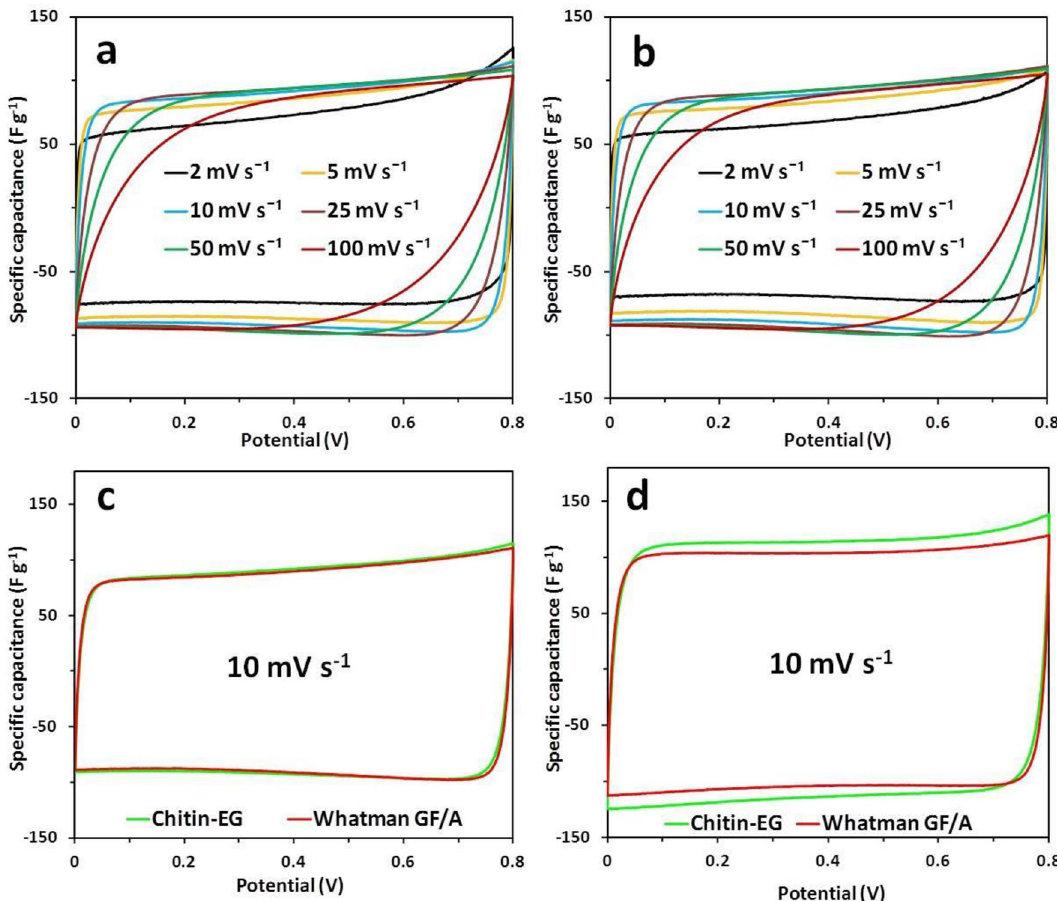
Figure 8. CV curves of EDLC test cells with ( a ) chitin–EG hydrogel and ( b ) Whatman GF/A glass fiber separator at different scan rates. Comparison of voltammograms recorded at the scan rate 10 mV s −1 ( c ) before the GCD test and ( d ) after 10,000 cycles of GCD.